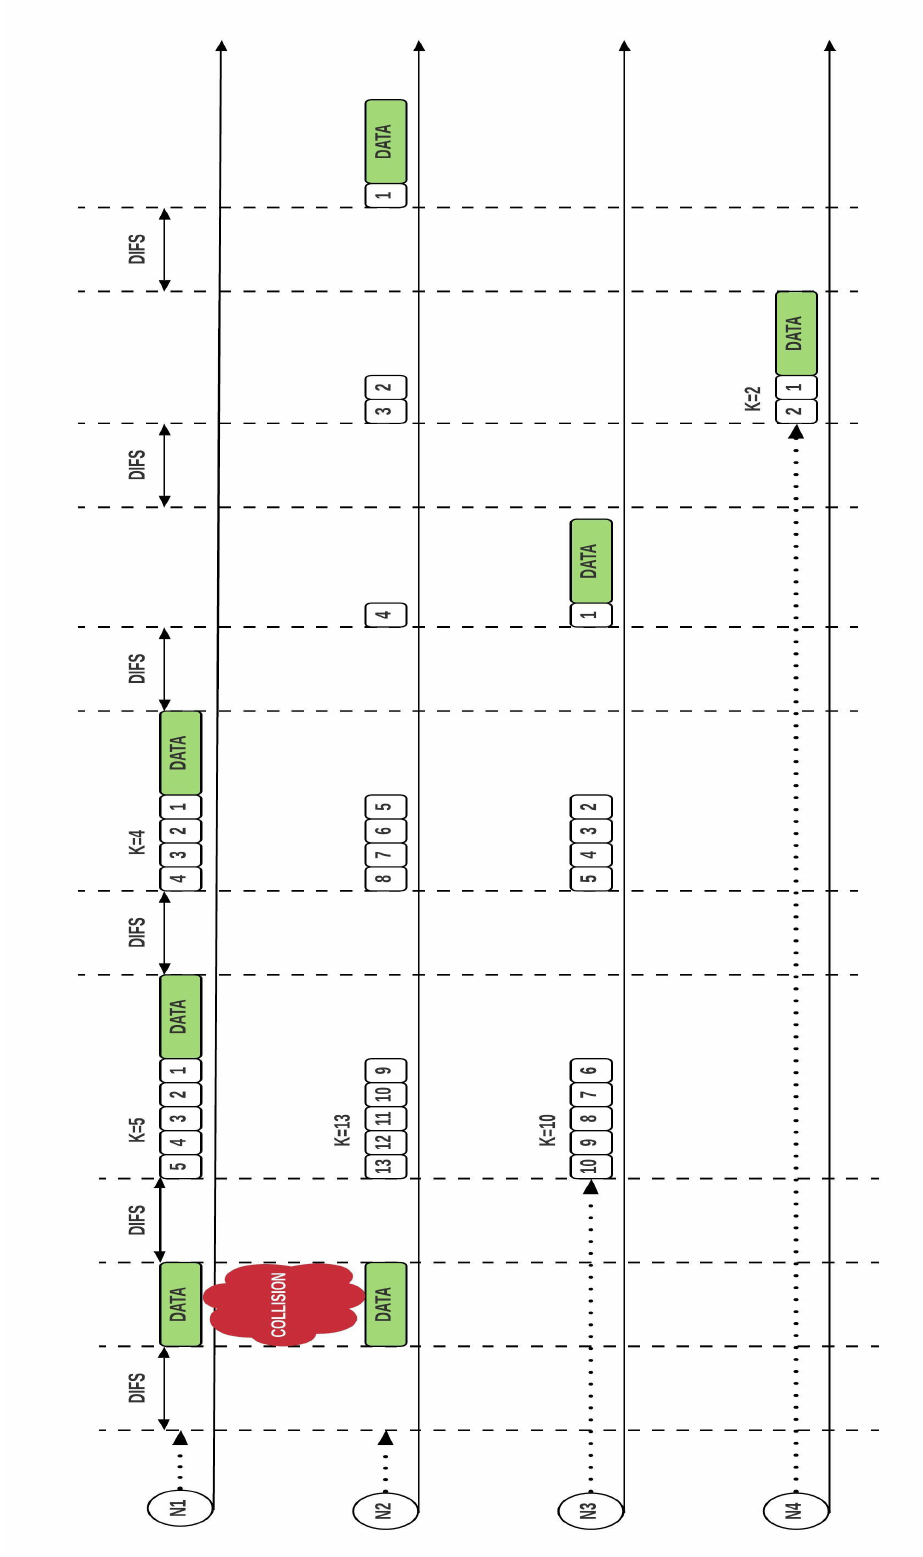
Figure 2. Four nodes competing for the channel using binary exponential backoff based distributed coordinated